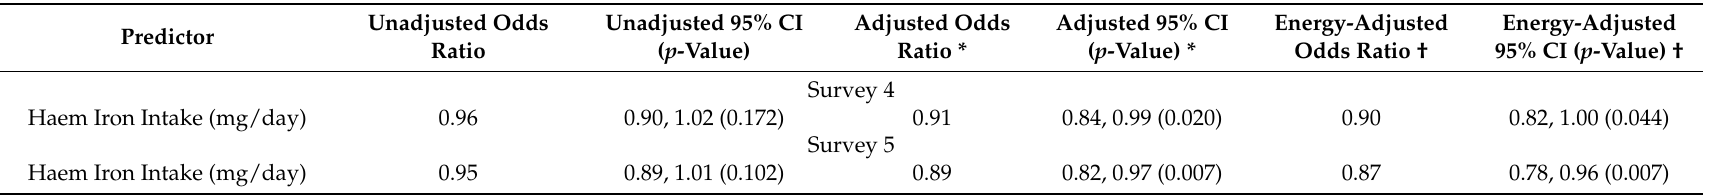
Table 3. Haem iron intake measured at survey 3 (baseline) and modelled as a predictor of self-reported diagnosed iron deficiency at survey 4 (2006) and survey 5 (2009) for Australian Longitudinal Study of Women’s Health young cohort women using univariate and multivariate logistic